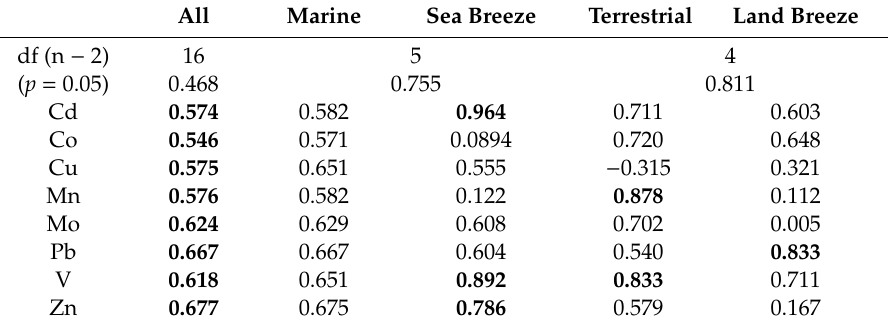
Table 1. Pearson correlation coe ffi cients between percentages of soluble Fe to total concentrations of anthropogenic elements normalised to total Ti atmospheric concentration. Significant Pearson’s r values in